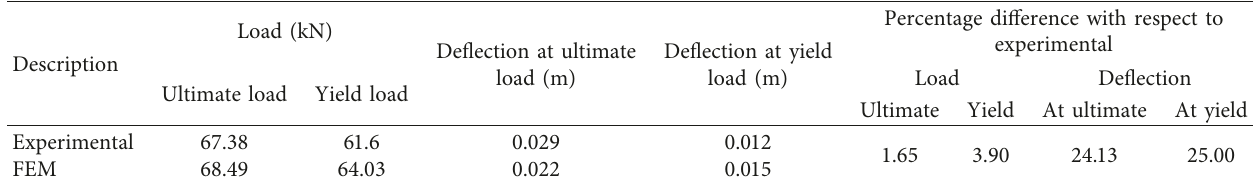
Figure 10: Comparison of the load-displacement response of the FEM and the experimental results of the reference specimen at the beam- free Table 3: Summary of numerical and experimental load-deflection results for the reference specimen.